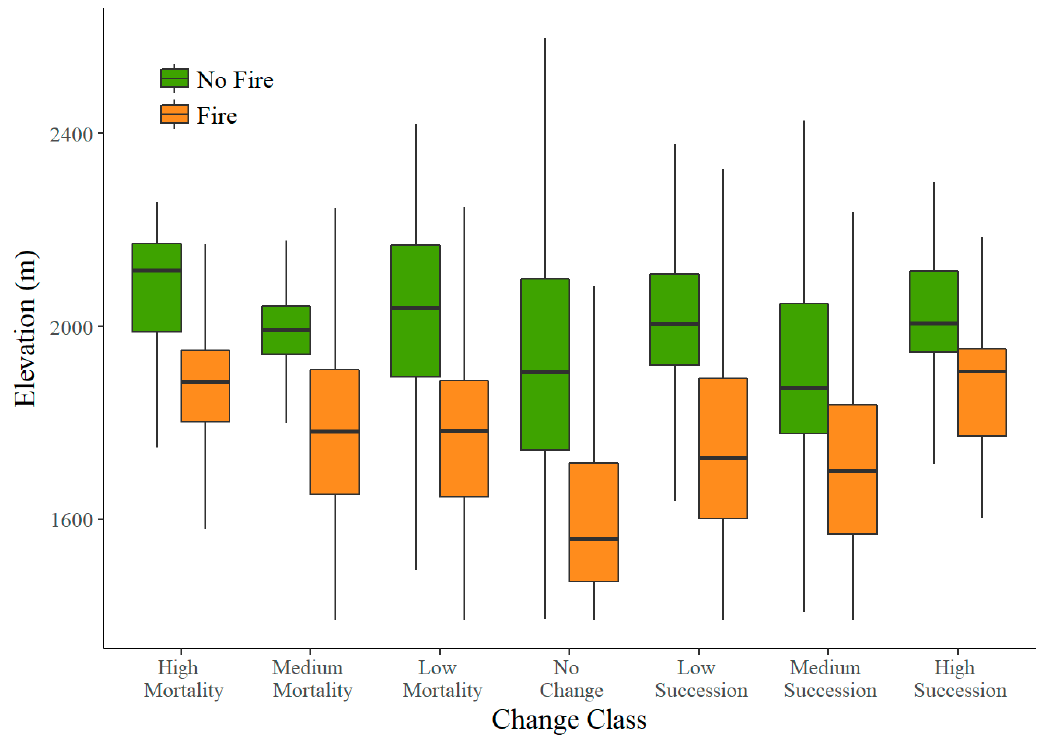
Figure 9. Distribution of elevation within change class, factored by fire exposure. In each canopy change class, median elevation is higher in areas that were not exposed to fire.